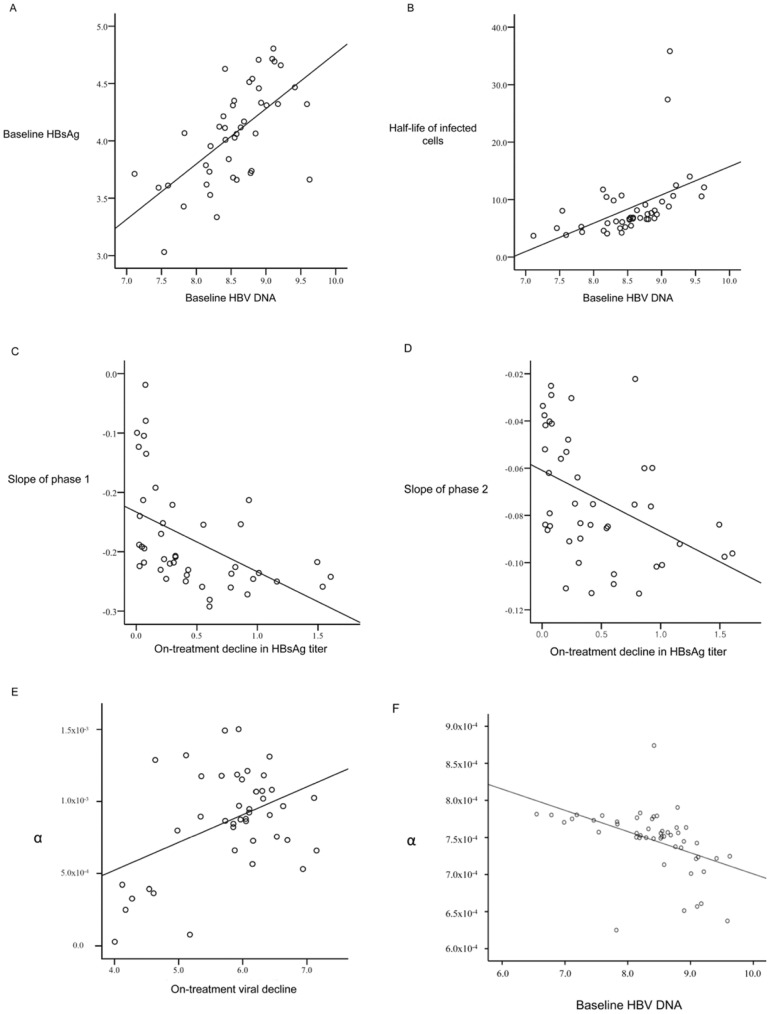
Linear regression analyses for the relationship between clinical characteristics and calculated parameters (Fig. 2-A–F).Baseline HBV DNA was significantly correlated with baseline HBsAg (2-A) and half-life of infected cells (2-B). Slopes of phase 1 and 2 showed correlation with on-treatment decrease in HBsAg titer (2-C,D). Calculated parameter “α”, or cytolytic activity-induced clearance rate of infected cells, was correlated with antiviral efficacy (2-E) and baseline HBV DNA (2-F). Abbreviations: HBV, hepatitis B virus; HBsAg, hepatitis B surface antigen.